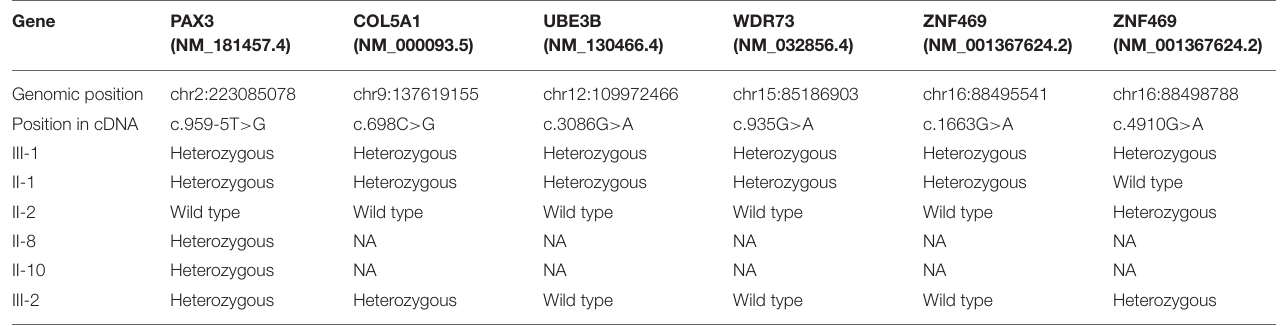
COL5A1 (NM_000093.5)